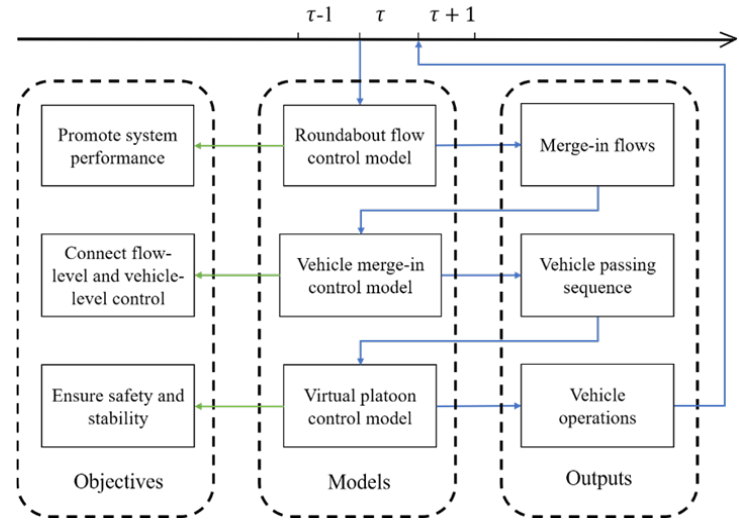
Figure 1. Conceptual structure of the roundabout control strategy.